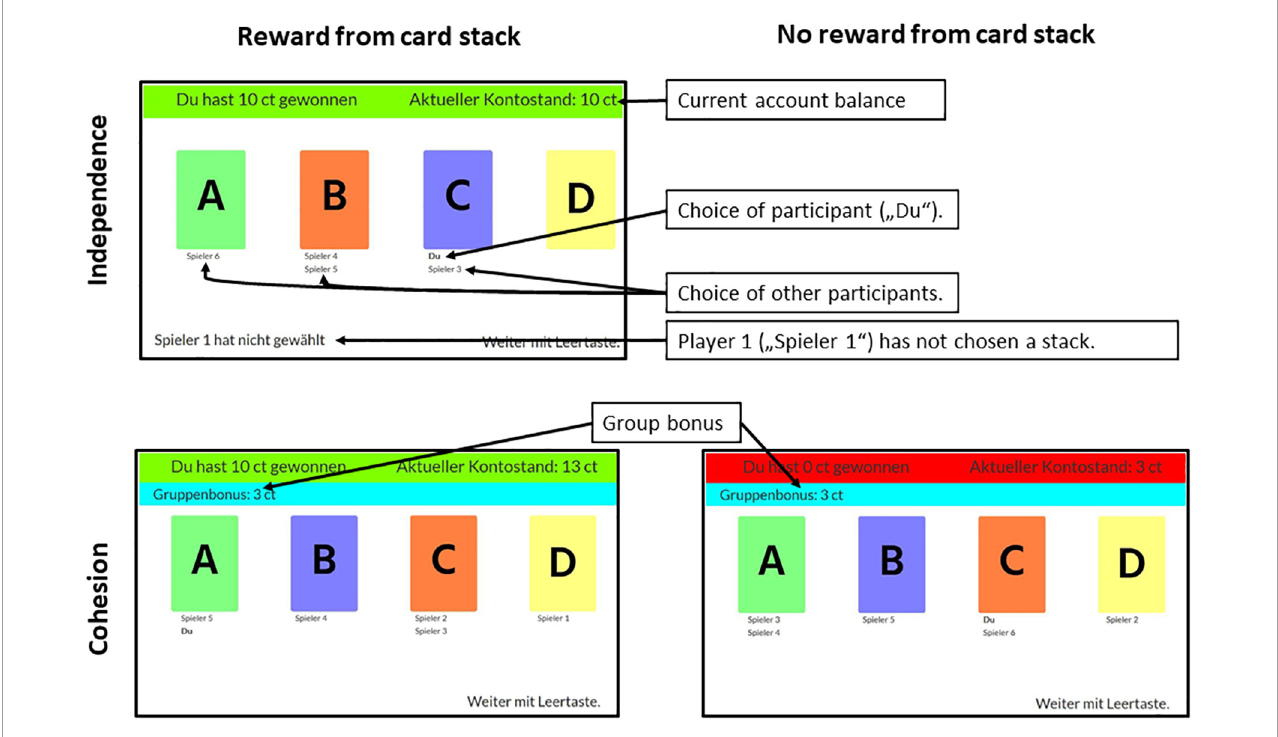
FIGURE2 Screenshots from the experiment as seen by participants. The (upper) screenshot shows a screen in the independent condition when the participant received a pay-out for choosing a card (green bar). The (lower) screenshots show the cohesion condition in which participants received a group bonus (blue bar) and received payout ( left , green bar) or did not receive payout ( right , red bar). Card stacks were colored differently and colors were randomly assigned in the beginning of each game. Participants were naïve to the exact pay-out probabilities and amounts and had to infer the best stack through exploring the different card